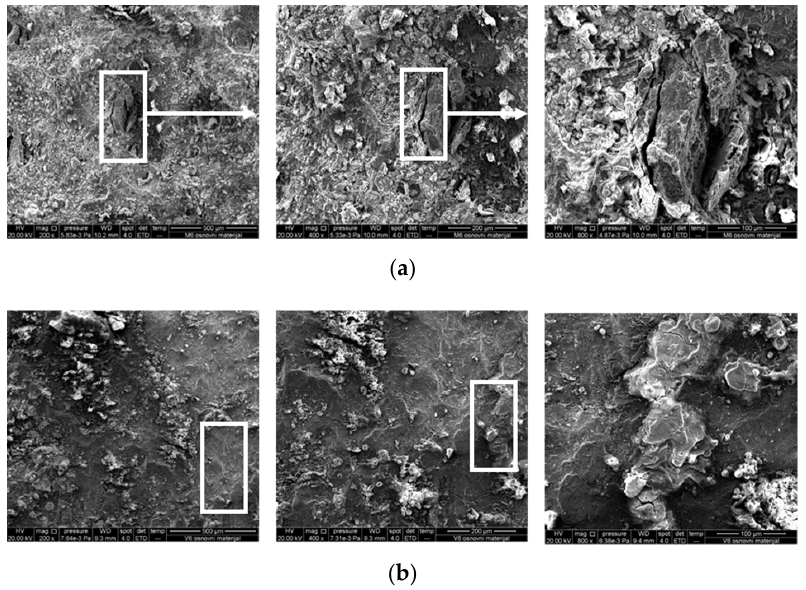
Figure 8. SEM images at magnification of 200×, 400×, and 800× for BM specimen area exposed for 6 months to: ( a ) sea water, ( b ) sea splash. 6 months to: ( a ) sea water, ( b ) sea